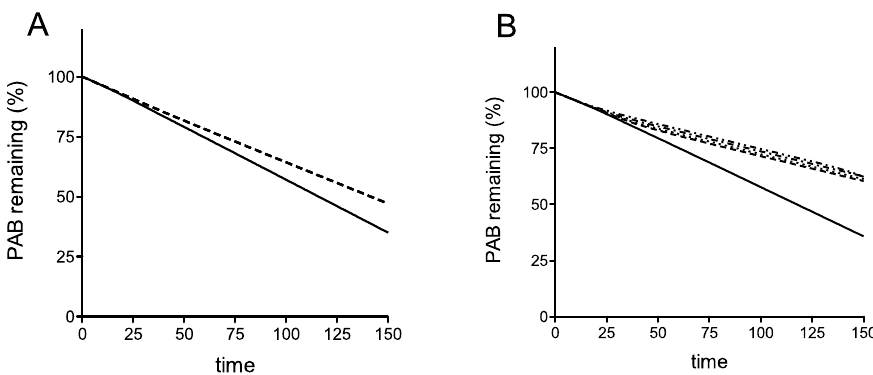
Figure 2. A deterministic model of translation including ribosome recycling can simulate the destabilization of an mRNA carrying an early stop codon, but not a late stop codon. ( A ) The position of the premature stop codon can play an important role in mRNA stability, indicated by the proportion of poly(A) binding protein remaining over time: the earliest stop codon (relative position 2; in the sequence of coarse-grained segments in the model, corresponding to the codon 22, solid line) has a reduced stability compared to the other four stop codon positions (Relative positions 12, 19, 27, 33 in the sequence of coarse-grained segments in the model; dotted lines, curves identical and therefore superimposed). In this iteration of the model, there is no recycle of ribosomes at the premature stop codon. ( B ) Introducing a propensity of the ribosome to recycle preserves the trends observed in panel A, although the effect of the early stop codon is accentuated, and there is a faster decay rate of the position 2 stop codon relative to the mRNA variants with a later position. A recycle propensity of 0.1 was employed for codon 2 (solid line) and 0.9 for all others (dashed lines).